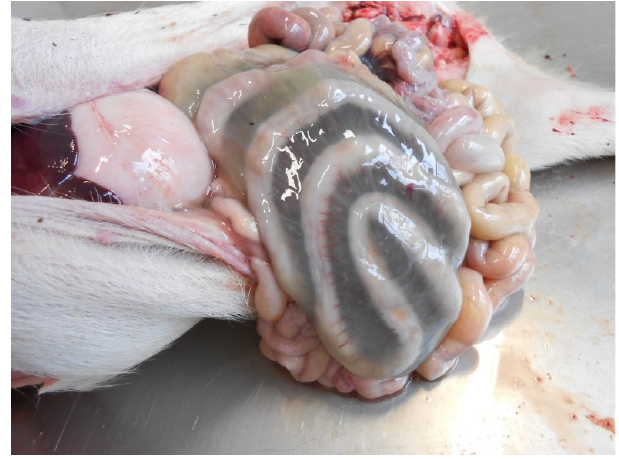
Figure 13. Piglet 5 days of age. Marked oedema of the mesocolon in a case of clostridiosis due to C. difficile .